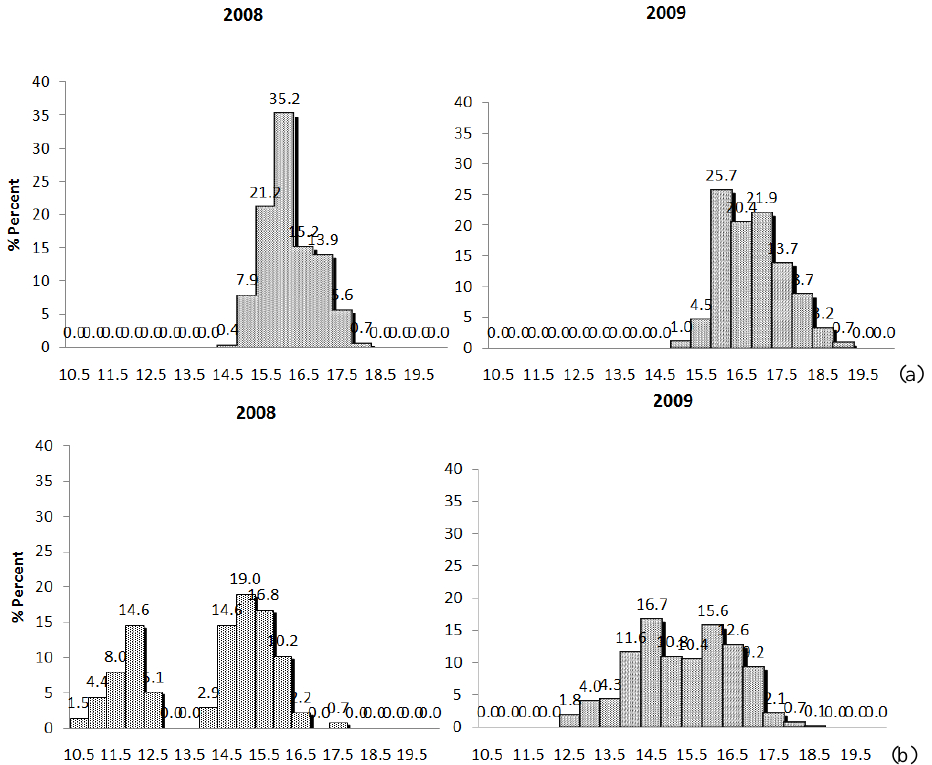
Fig. 3. Catch of carduma ( Cetengraulis mysticetus ) in percentage of individual fish per size interval in the Cauca-Nari˜no marine corridor during 2008 and 2009. (a) Industrial fleet. (b) Artisanal fleet.